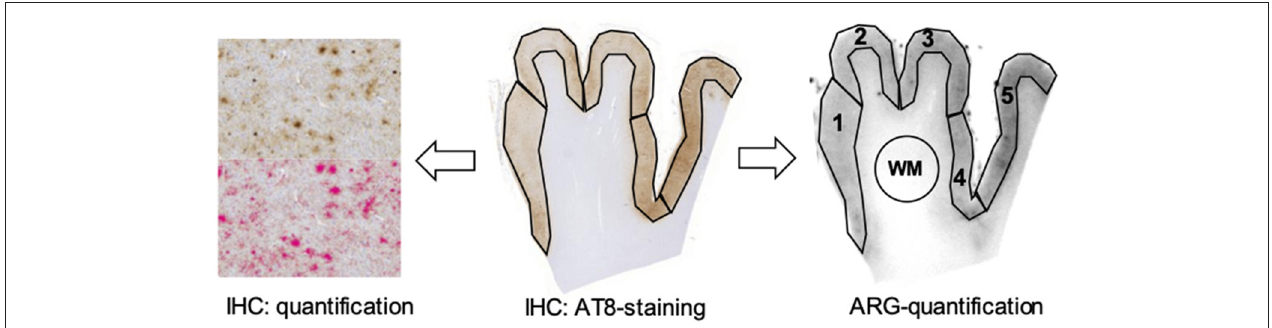
FIGURE 1 | Tau load quantification in immunohistochemistry (IHC) samples with AT8-staining based on color thresholds on the left (upper image: original AT8 image, bottom image: all parts within the threshold marked in pink) and quantification of autoradiography signal (ARG) in corresponding frontal cortex brain areas (on the right). The subcortical white matter (WM) was used as a reference